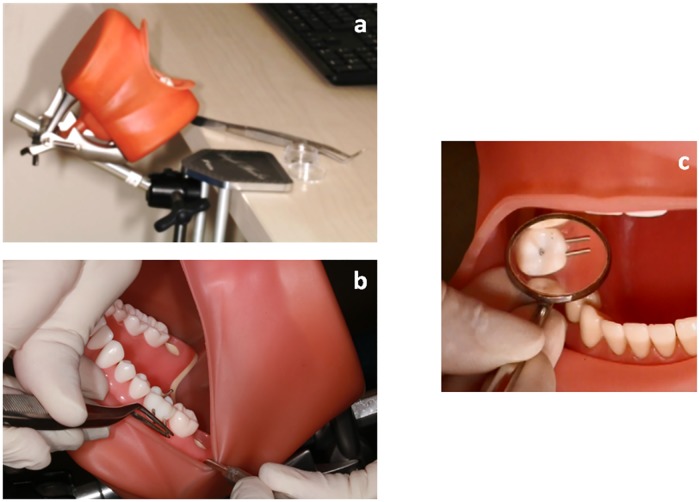
The PhantHome—Novel portable tool.(a) The tool is attached to a desk. (b) (c) "Intra-oral" view of the teeth with inserted pins.